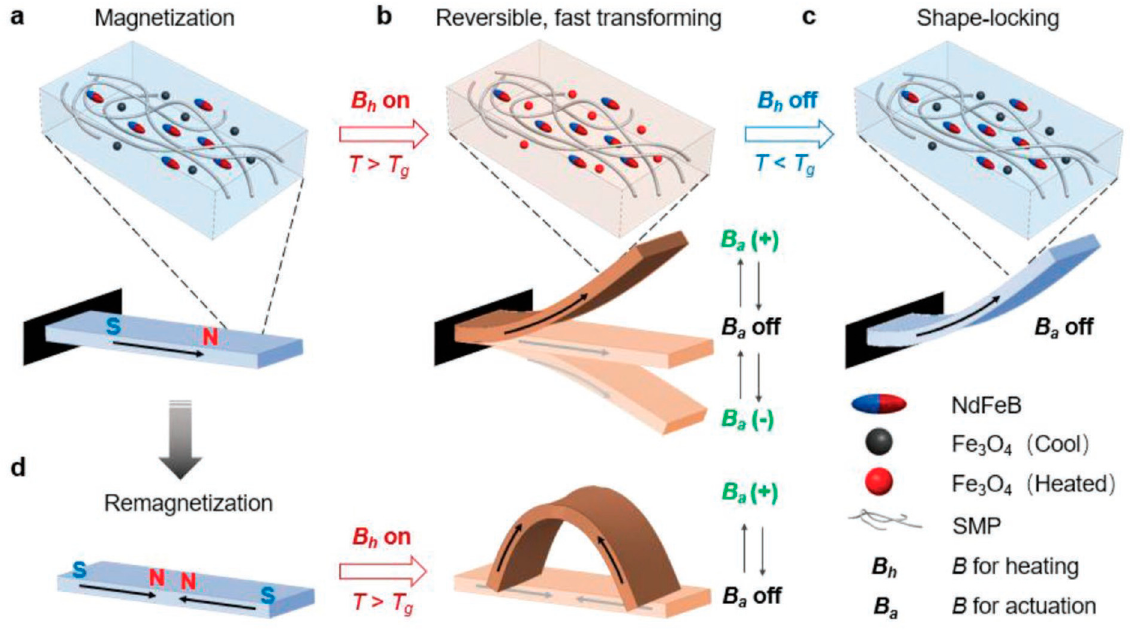
Figure 13. Magnetic shape memory polymer composite. ( a ) Before actuation. ( b ) After induction heating. ( c ) Shape locking of the MSMP composite [54] .